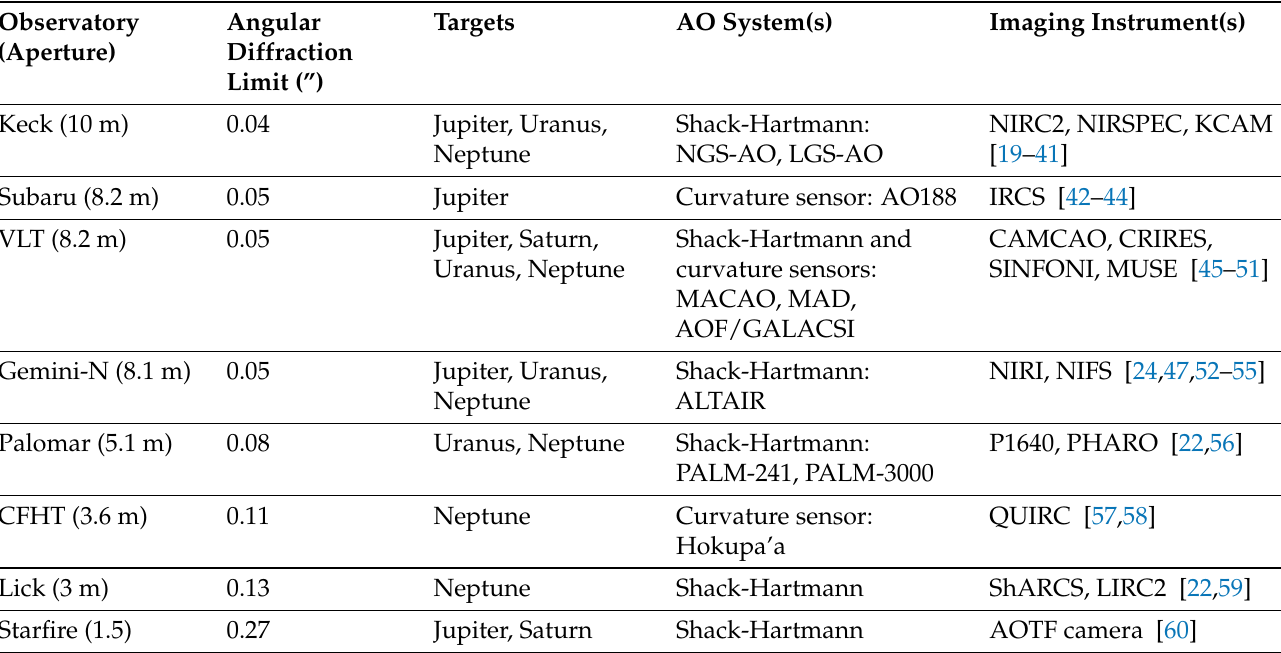
Table 2. Adaptive Optics Observations of Giant Planet